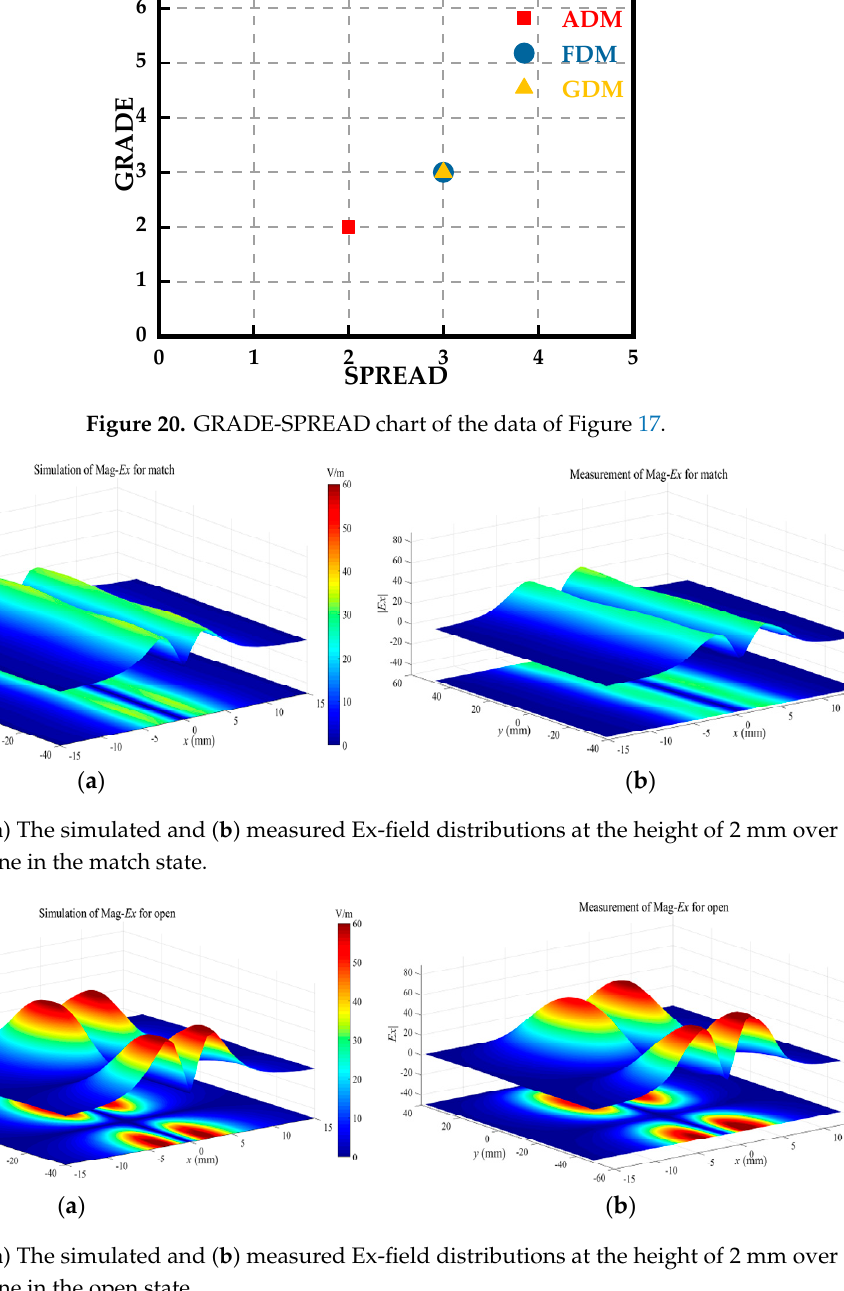
microstrip line in the open state.